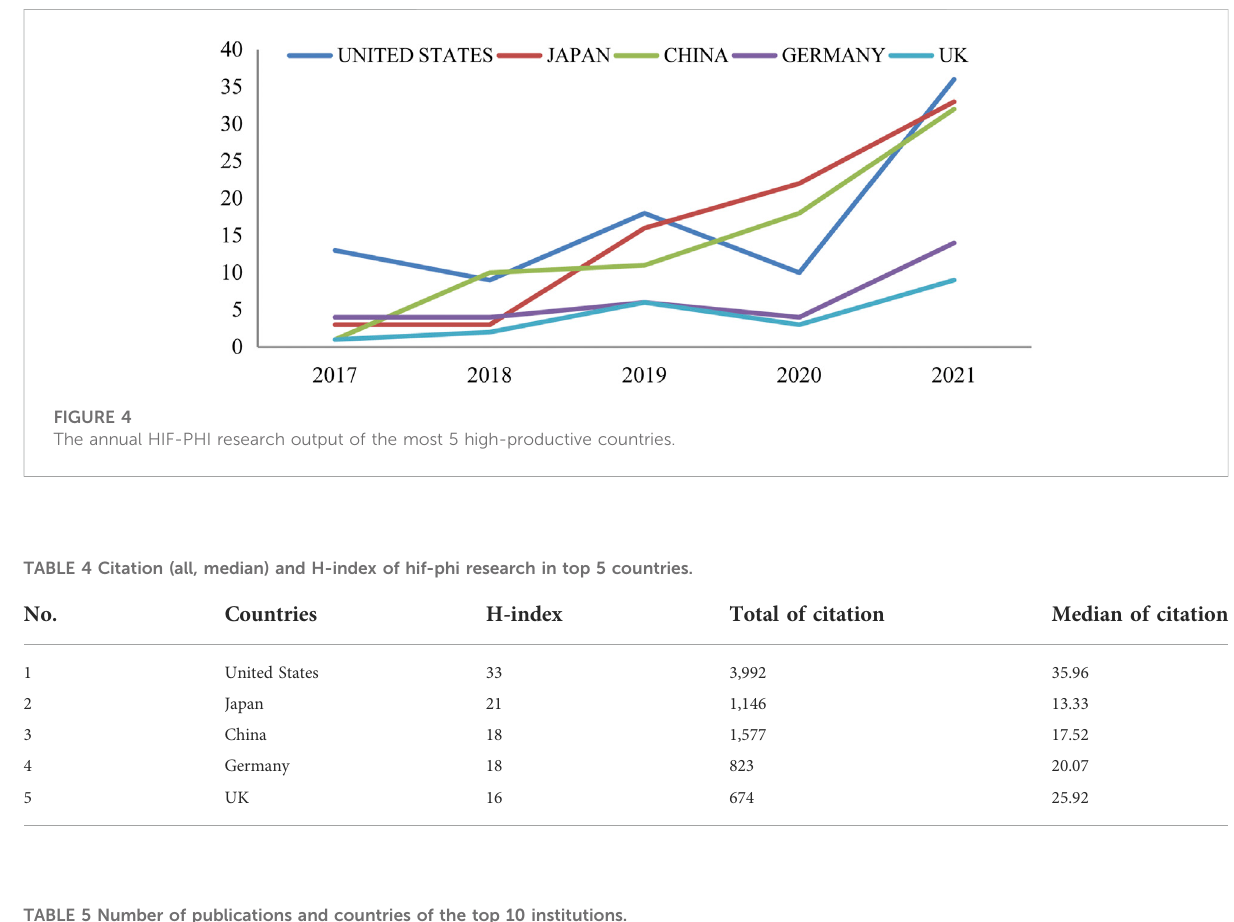
TABLE 5 Number of publications and countries of the top 10 institutions. No. Institutions Countries Number